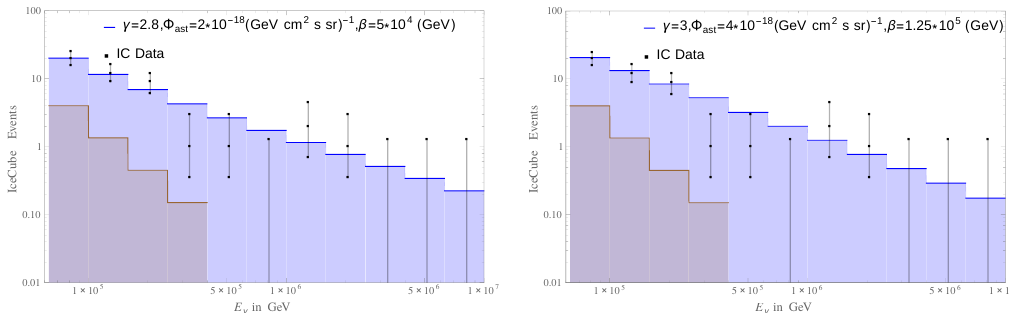
Figure 5 . IceCube event distribution for neutrino splitting with a. moderate (cid:13)ux amplitude, relatively (cid:13)at spectrum and small decay e(cid:11)ects ((cid:8) 0 = 2 (cid:2) 10 (cid:0) 18 (GeV cm 2 s sr) (cid:0) 1 , (cid:13) = 2 : 8, astro (cid:12) = 5 (cid:2) 10 4 GeV) (left) b. higher (cid:13)ux amplitude, steeper spectrum and higher decay e(cid:11)ects ((cid:8) 0 = 4 (cid:2) 10 (cid:0) 18 (GeV cm 2 s sr) (cid:0) 1 , (cid:13) = 3, (cid:12) = 1 : 25 (cid:2) 10 5 GeV) (right). Atmospheric neutrino astro background is shown as brown shaded region.